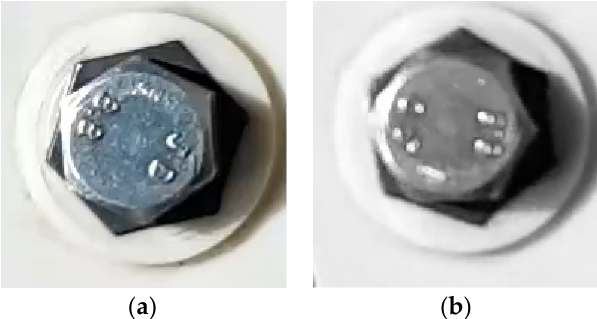
Figure 3. First ( a ) and thousandth ( b ) frames of the video. Notice how the image (b) is out of focus and the center of the screw is translated upwards. N.B., The selected (cid:1876) coordinate goes from left to right, while the (cid:1877) coordinate goes from the top to the bottom, differently from the standard. while the y coordinate goes from the top to the bottom, di ff erently from the